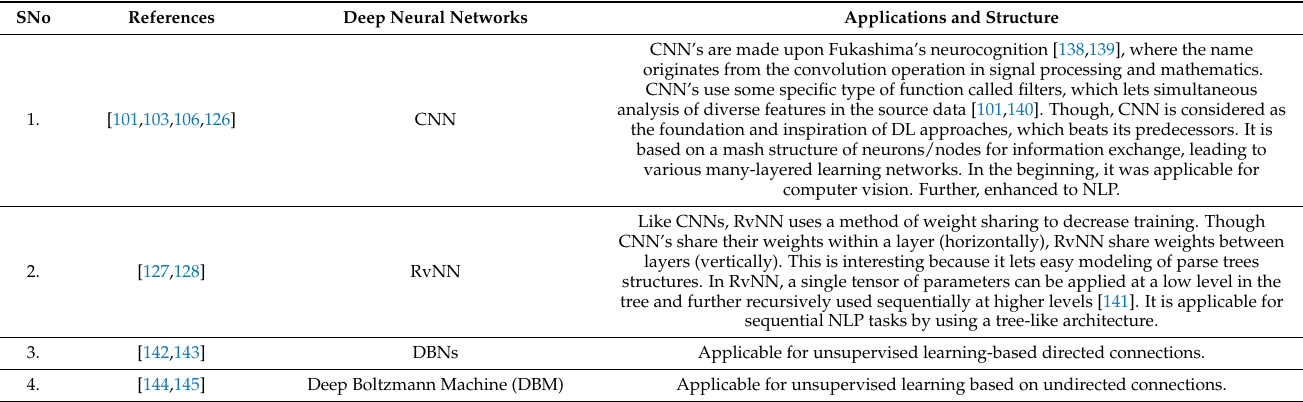
Table 3. Common Deep learning models for NLP